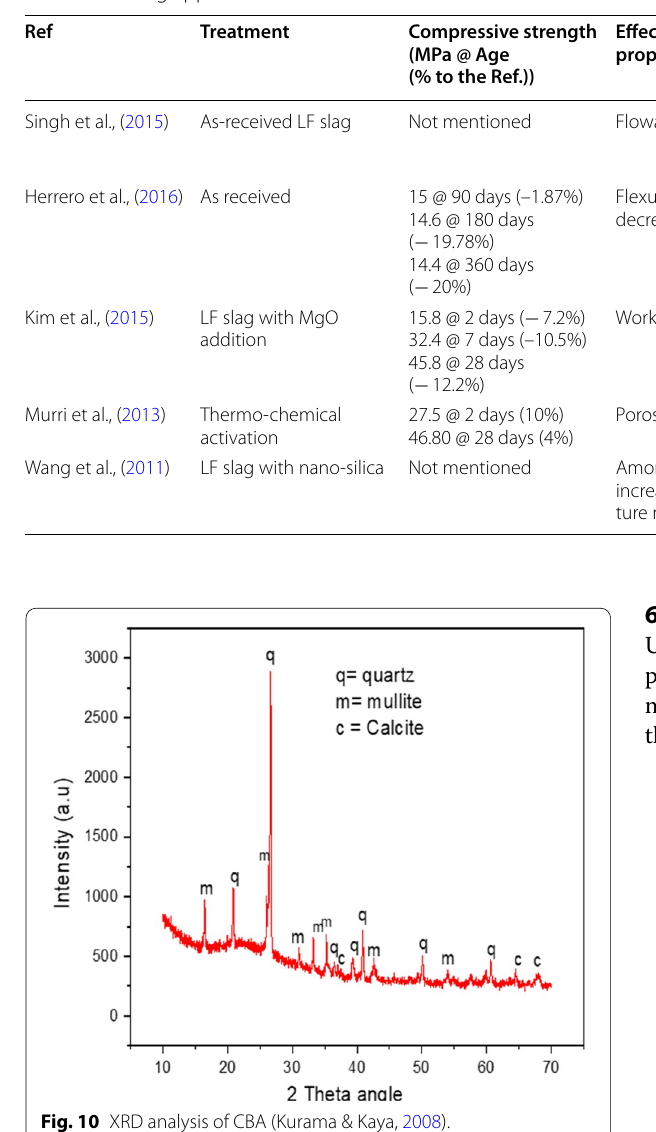
Table 7 LF slag application as a cementitious